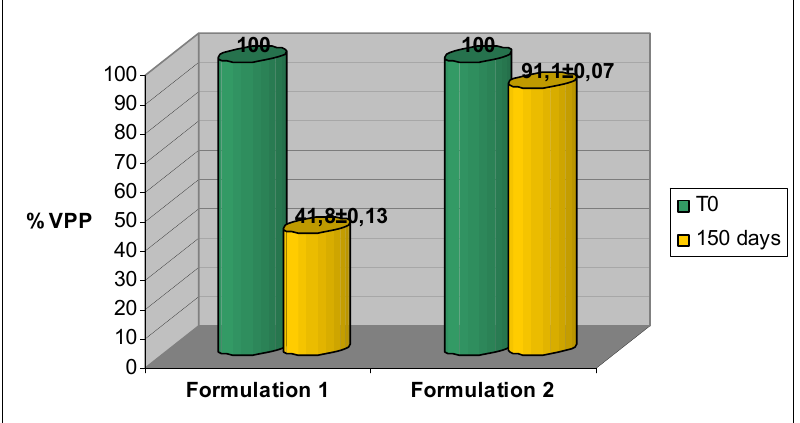
Figure 6. VPP recovery rate in the different formulations stored at 40 °C. Each value was obtained from three experiments (mean ±